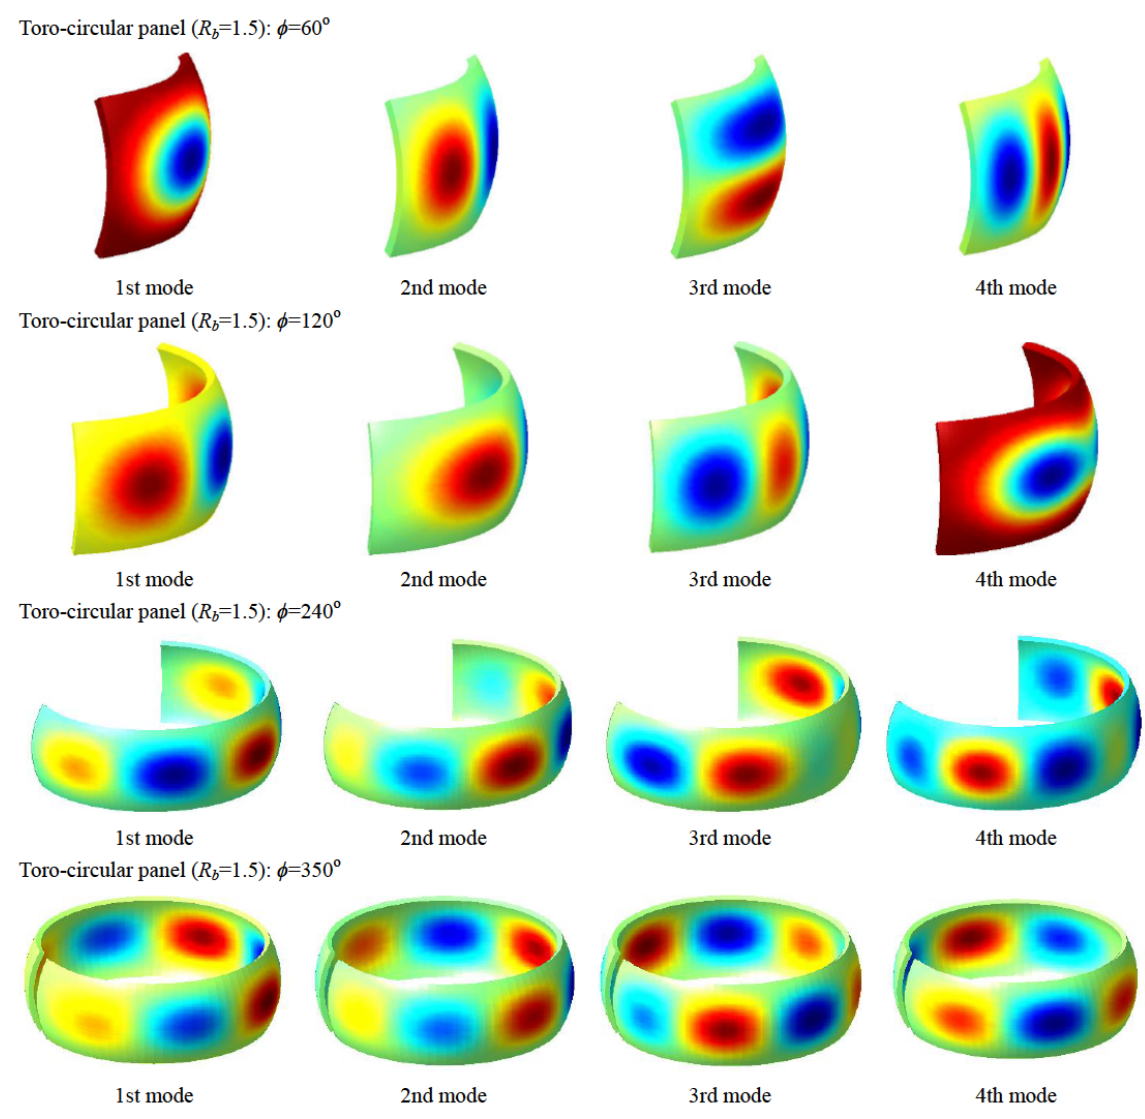
Figure 7: Mode shapes of the Toro-circular panel ( R b = 1.5) with CE 1 CE 1 boundary